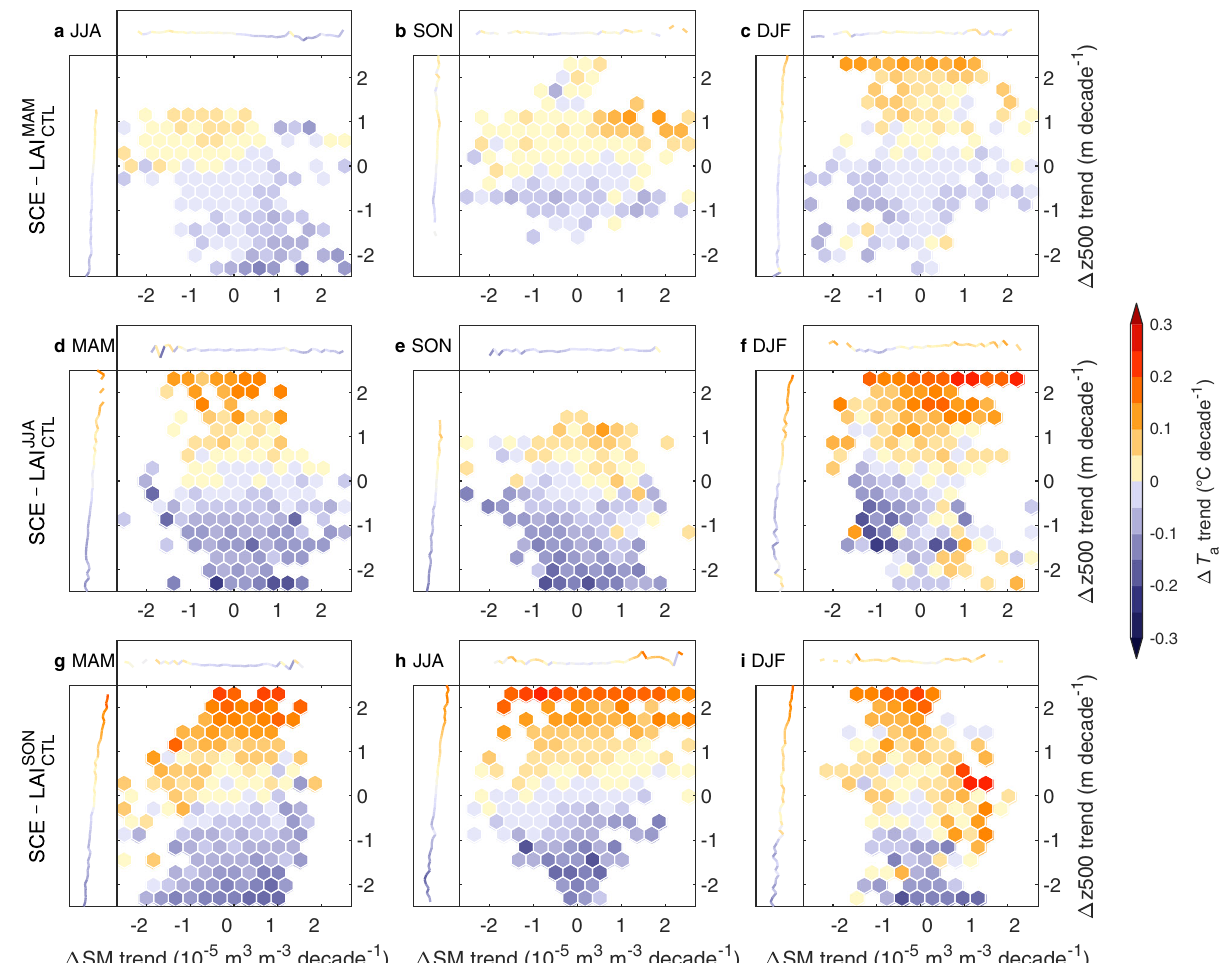
Fig. 5 Biophysical processes underlying inter-seasonal temperature responses to greening. Distribution of the Δ T a (air temperature) trend in the space of the Δ SM (soil moisture) trend and the Δ z500 (500 hPa geopotential height) trend, all induced by MAM ( a , d , g ), JJA ( b , e , h ), and SON ( c , f , i ) leaf area index (LAI) changes. Marginal curves indicate the partial dependence of the Δ T a trend on the Δ SM trend (top) and the Δ z500 trend (left). MAM